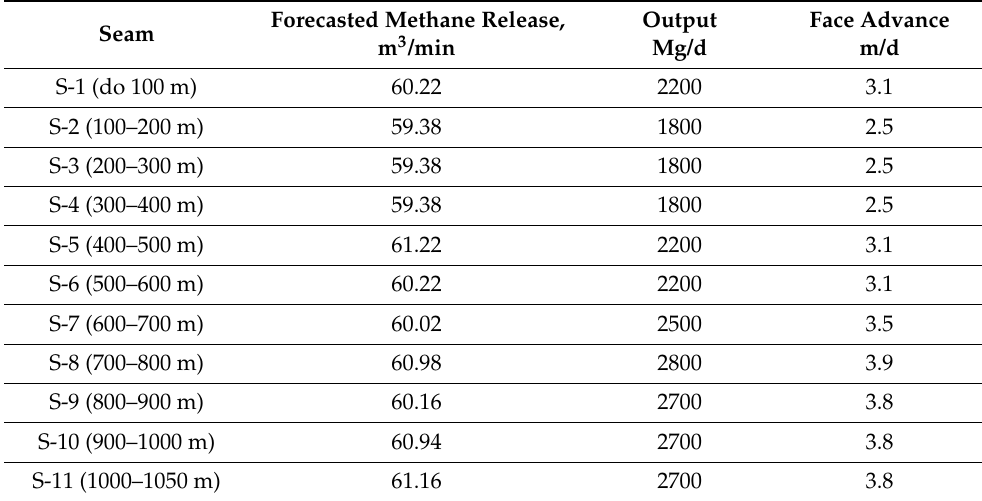
Table 6. Forecasted methane release for the section of longwall B-15 inseam 348. Forecasted Methane Release, Seam m 3 /min